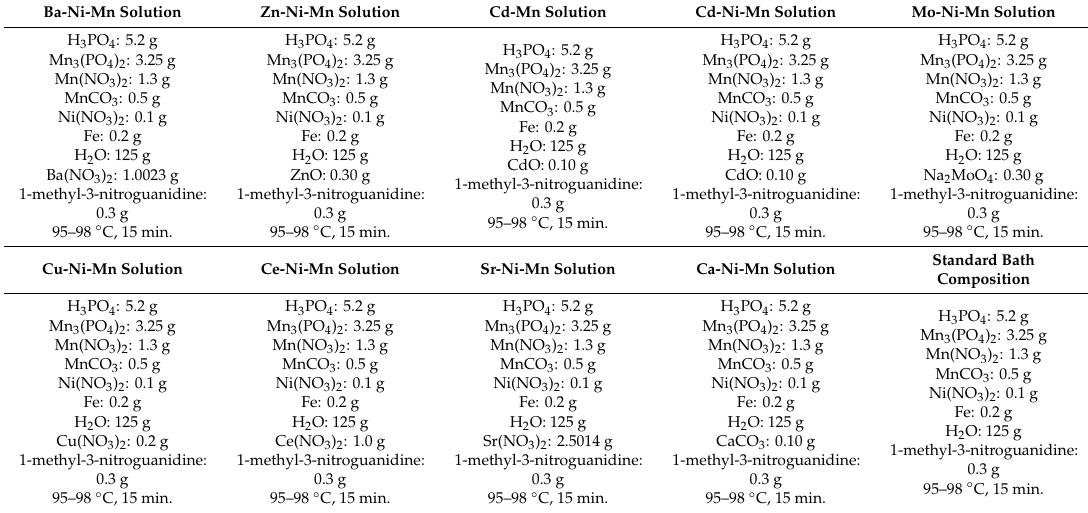
Table 4. Chemical composition and working conditions for modified phosphate baths. Ba-Ni-Mn Solution Zn-Ni-Mn Solution Cd-Mn Solution Cd-Ni-Mn